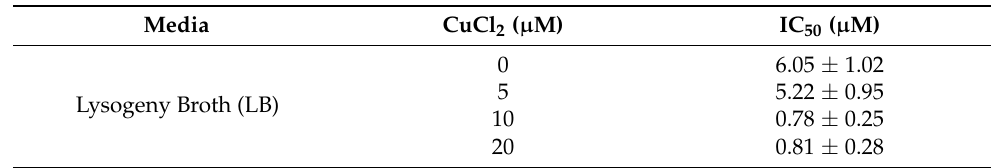
Table 1. Pyrithione inhibitory concentrations for the Keio collection E. coli reference strain, BW25113 . Cells growing in complex media (LB) were subjected to varying pyrithione concen- trations in the presence of incremental concentrations of CuCl 2 . Inhibitory concentrations as IC 50 values are shown as the mean and standard deviation of four